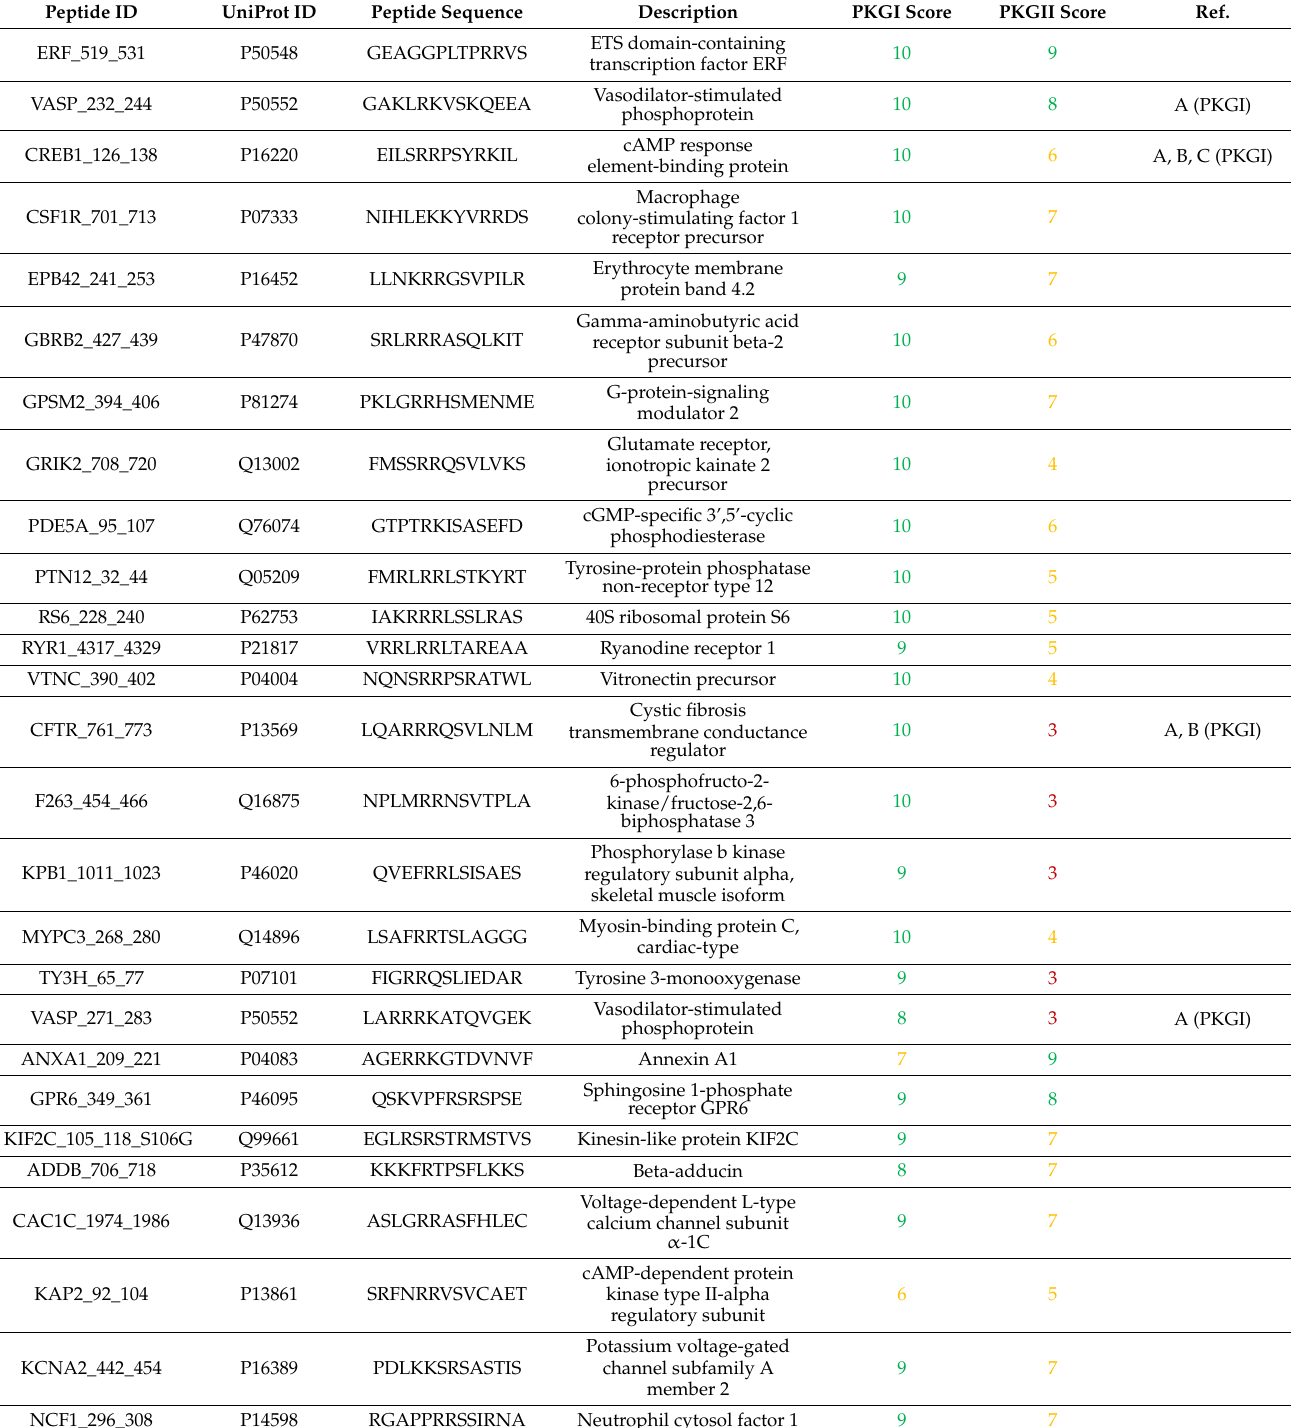
Table 2. Peptide substrates for PKGI and PKGII, their sequence, protein name, UniProtID and score. Scores for PKGI and PKGII range from 1 to 10. For sites already known to be phosphorylated by PKGI or PKGII, the database containing this information is added. A—PhosphoSitePlus ® , B—Human Protein Reference Database, C—UniProt. Color scheme according to the score—10–8: Good, 7–4: Intermediate and 3–0: Poor